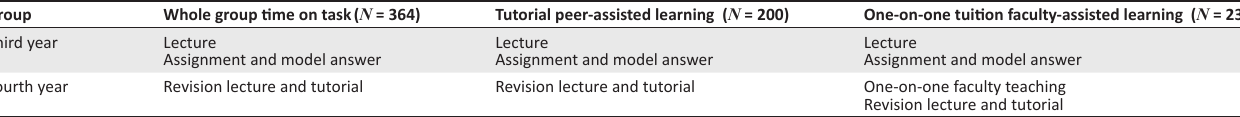
TABLE 1 : Training offered. Group Whole group time on task ( N = 364) Tutorial peer-assisted learning ( N =